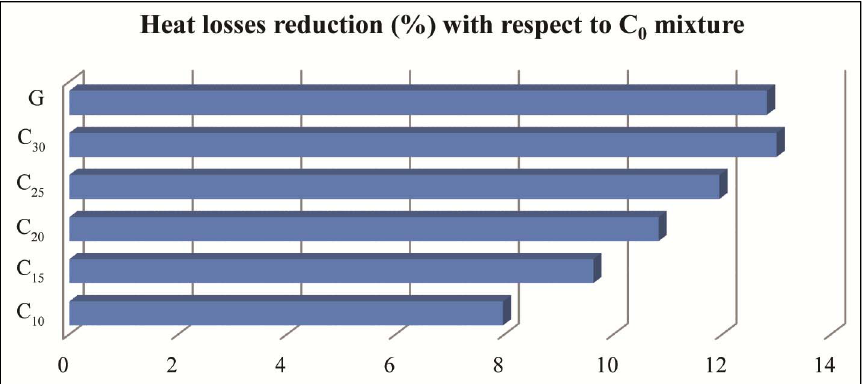
Figure 11. Heat losses reduction (%) obtainable by using the present concrete mixtures, mixture. with respect to C 0